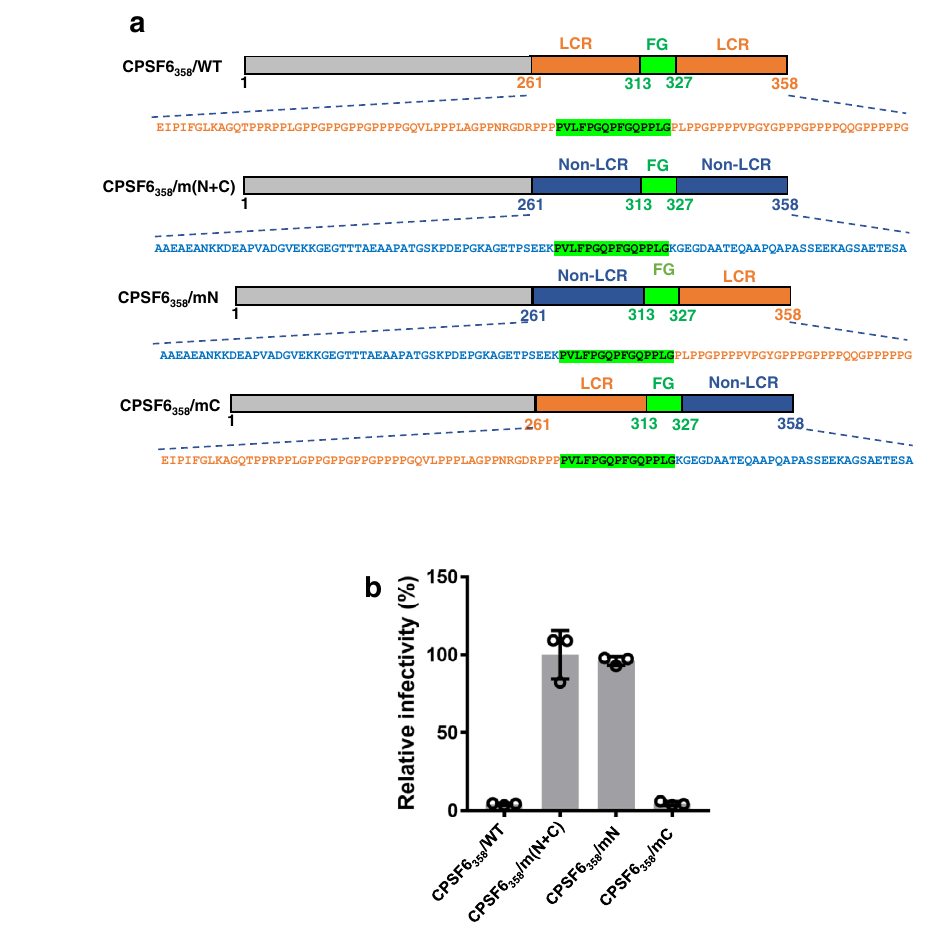
Fig. 8 | HIV-1 infectivity assays probing roles of N- and C-termini CPSF6 LCRs. a Schematic of WT CPSF6 358 and corresponding mutant proteins stably over- expressedinHelacells.CPSF6 358 /m(N+C):bothN-andC-terminiCPSF6LCRswere replaced with non-LCR sequences from NEURM 97-179 . CPSF6 358 /mN: the N-terminal LCR was replaced with non-LCR sequences from NEURM 97-179 . CPSF6 358 /mC: the